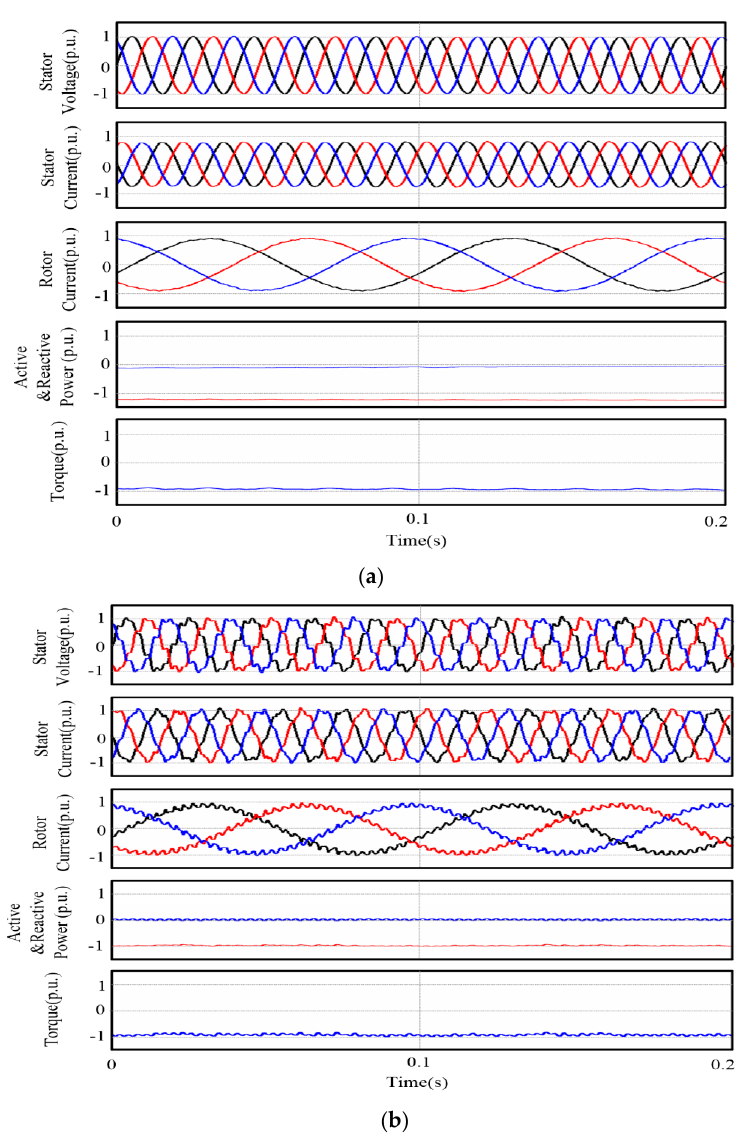
Figure 18. Simulation results of DFIG system in weak grid with SRF-PLL (a) Low bandwidth; and, (b) High bandwidth.